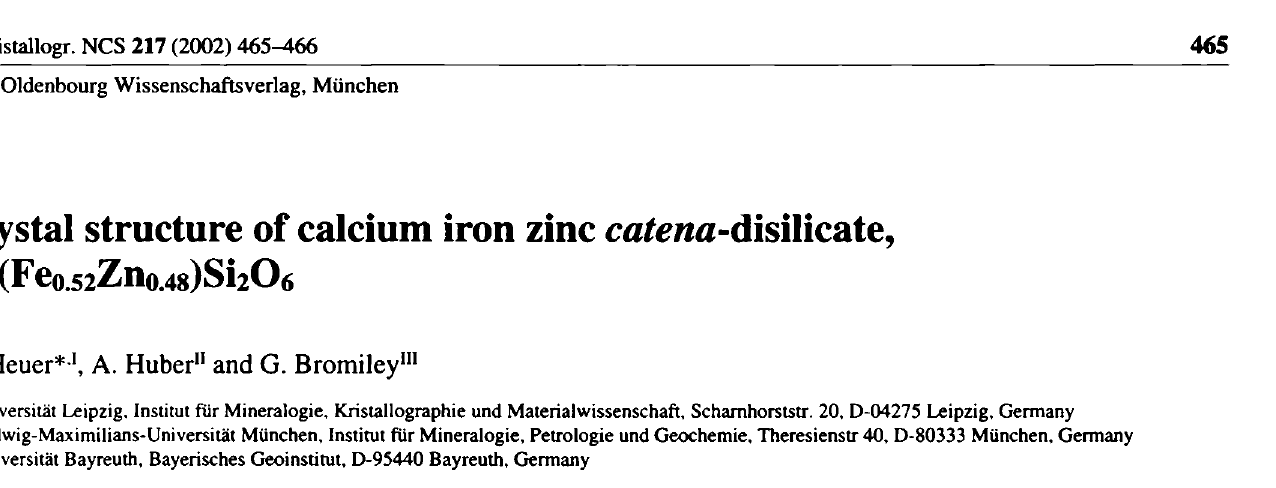
Table 1. Data collection and handling.